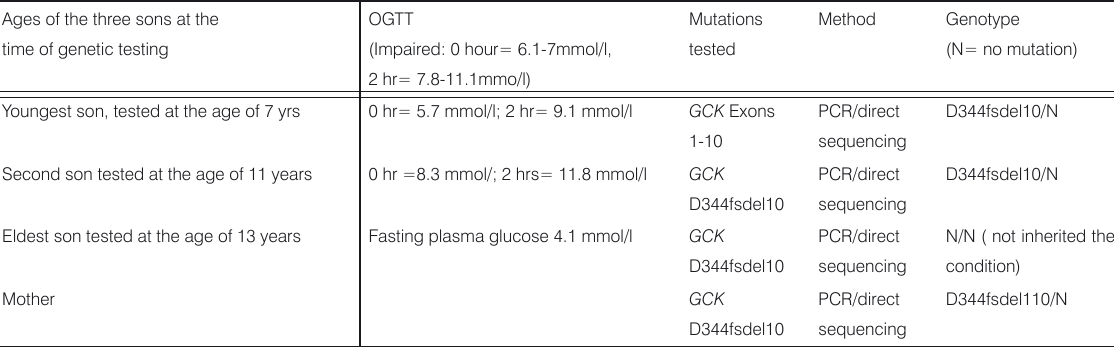
Table 5. Showing the GCK mutation of the mother and her sons.